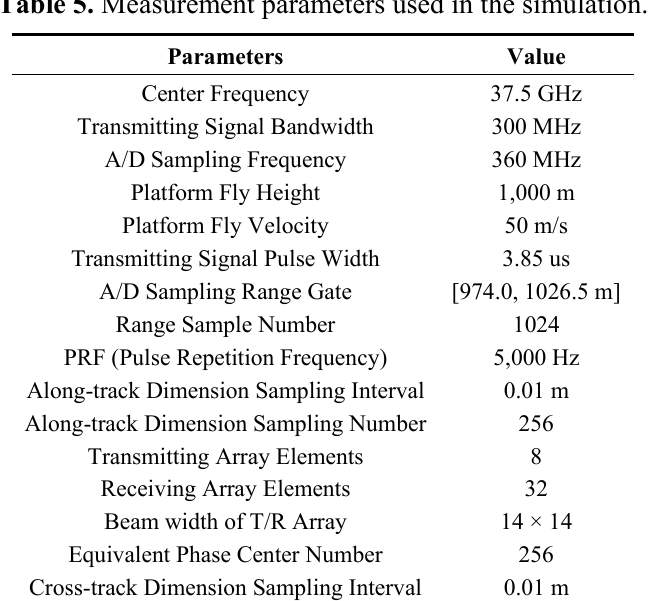
Table 5. Measurement parameters used in the